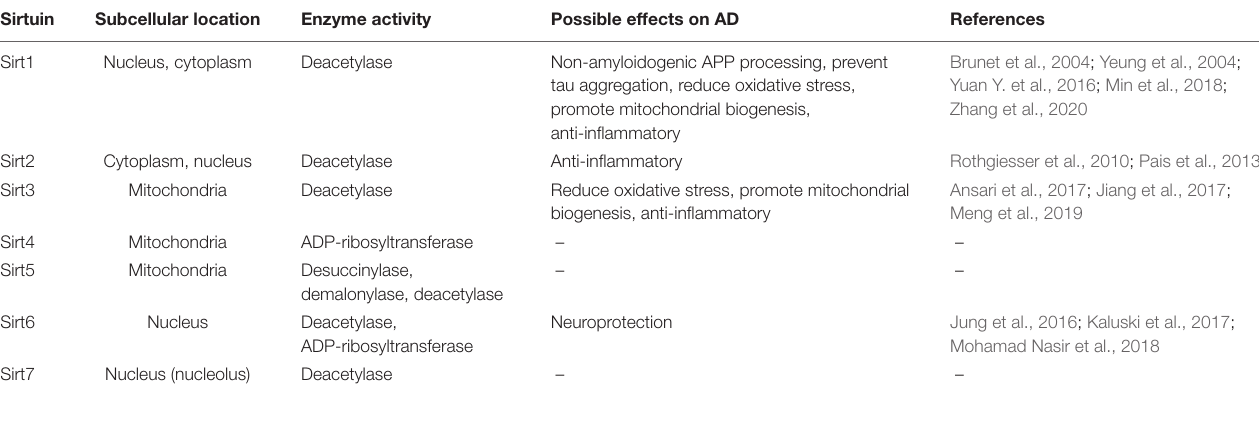
TABLE 1 | Subcellular location and enzyme activity of sirtuins and their potential effects on Alzheimer’s disease.